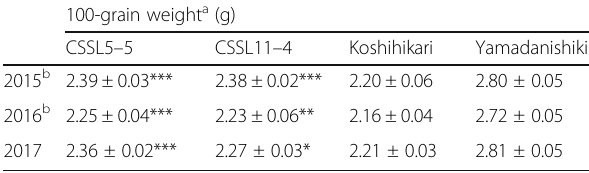
Table 3 One hundred grain weight of parents and CSSLs harboring qOPW5 and qOPW11